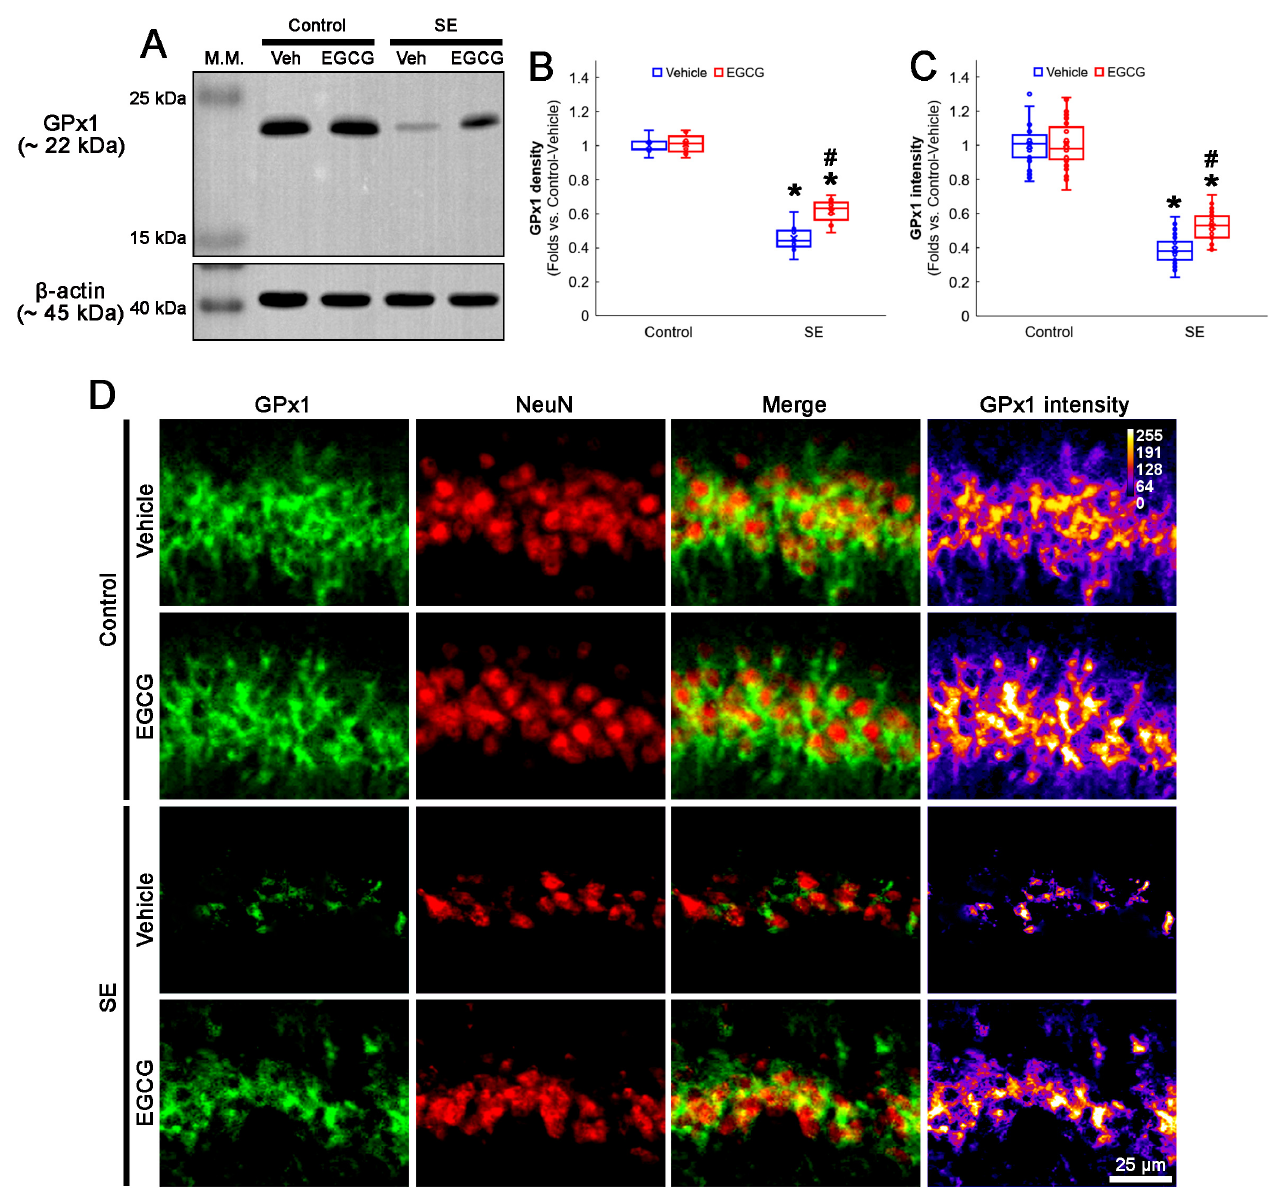
Figure 3. Effects of EGCG on GPx1 expression following SE. Western blot data showed that GPx1 expression decreased in SE group, compared with control animals. In control animals, EGCG did not affect GPx1 expression. EGCG attenuated the reduced GPx1 expression in SE group ( A – C ). Immunofluorescent study also revealed that GPx1 expression was reduced in CA1 neurons of SE group, compared with control animals. In control animals, EGCG did not affect GPx1 expression in CA1 neurons. EGCG attenuated the decreased GPx1 expression in the CA1 neurons of SE group ( D ). ( A ) Representative Western blot of GPx1 in the whole hippocampus. ( B ) Quantification of GPx1 protein level based on Western blot data (* and # p < 0.05 vs. control and vehicle-treated rats; n = 7 rats, respectively). ( C ) Quantification of GPx1 intensity in CA1 neurons (* and # p < 0.05 vs. control and vehicle-treated animals; n = 35 cells in 7 rats, respectively). ( D ) Representative photos of GPx1 expression and its intensity.